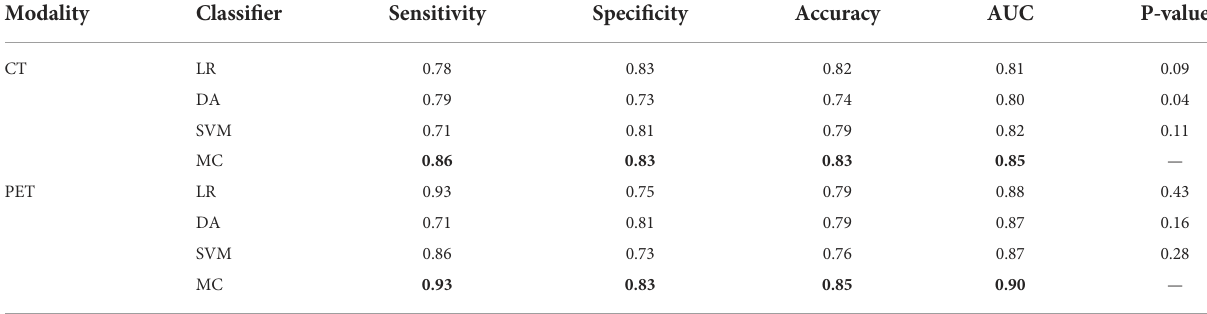
TABLE 3 Performance comparison of single classi fi er radiomics models and multi-classi fi er (MC) radiomics models. Modality